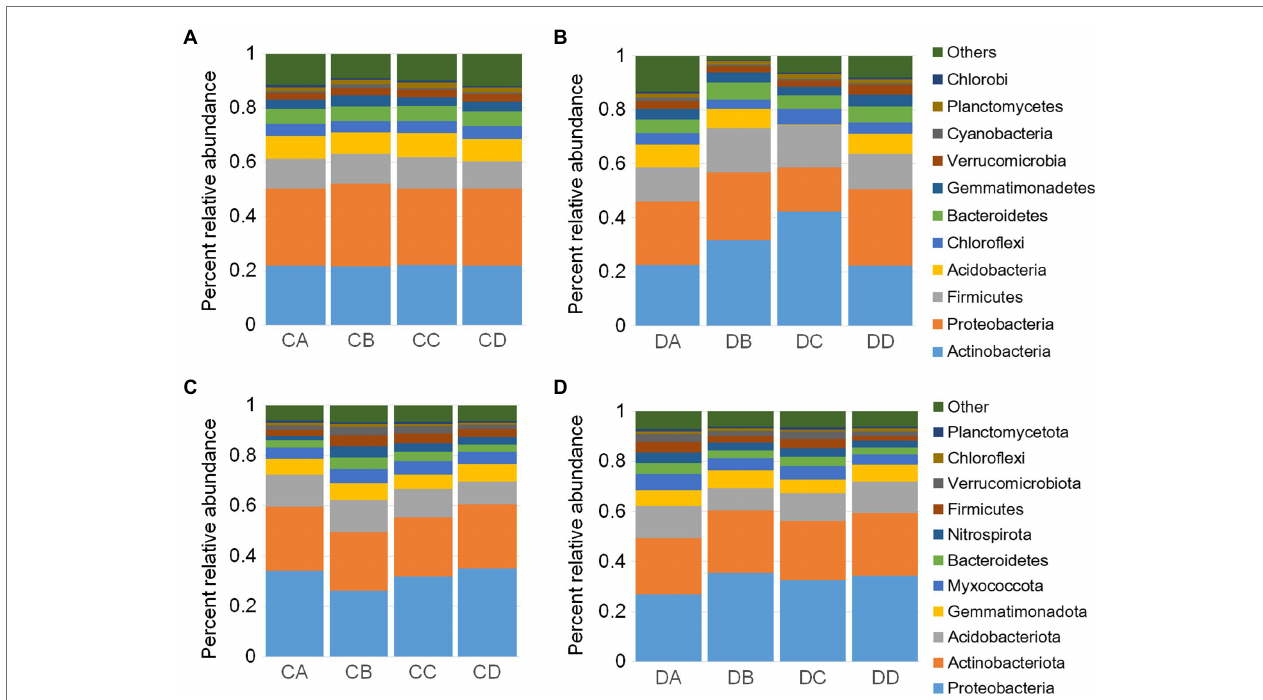
FIGURE 2 | Drought impacts root microbiome development. Percent relative abundances of the top 11 most abundant phyla for rhizosphere samples of the control (A) and drought treatment (B) . Percent relative abundances of the top 11 most abundant phyla for bulk soil samples of the control (C) and drought treatment (D) . DA, drought sample A; DB, drought sample B; DC, drought sample C; DD, drought sample D; CA, control sample A; CB, control sample B; CC, control sample C; CD, control sample